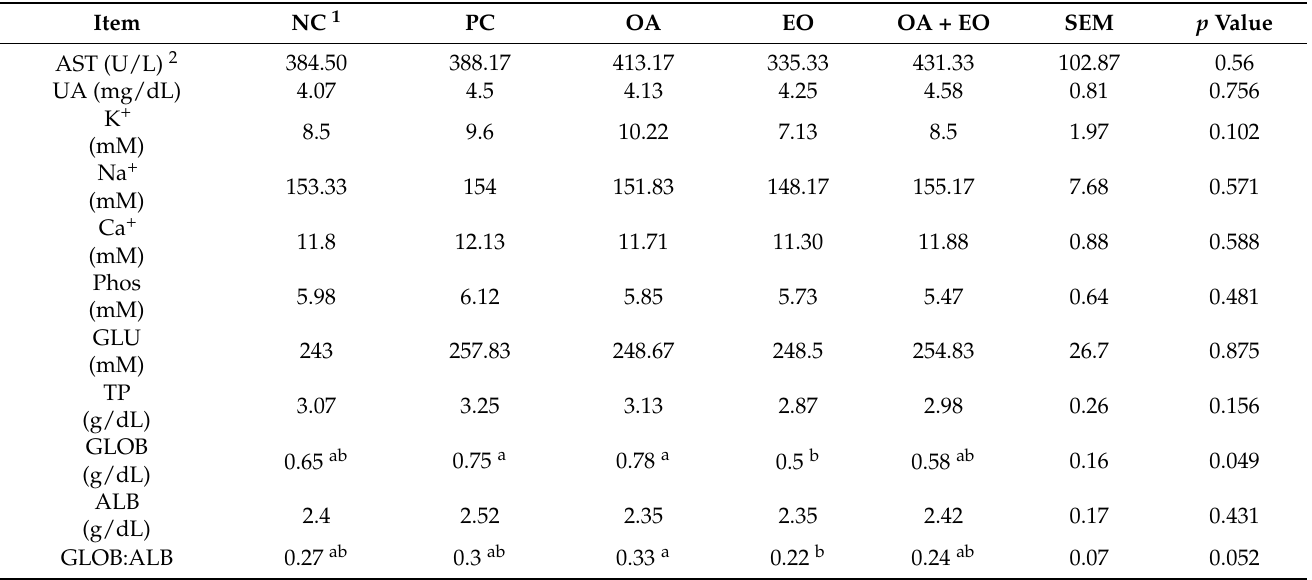
Table 3. Effects of individual or combination of organic acids and essential oils on the serum biochemistry of broiler chickens on D